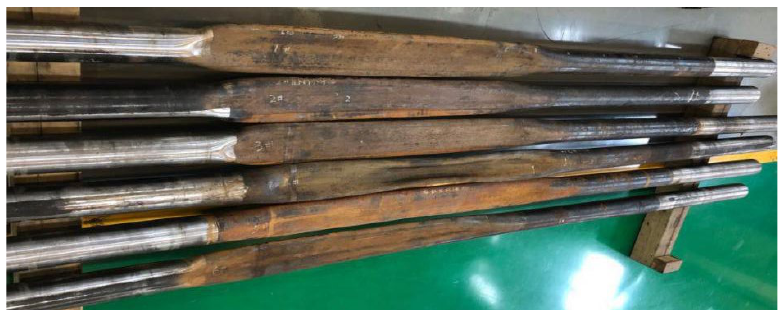
Figure 6. The specimens after collapse.